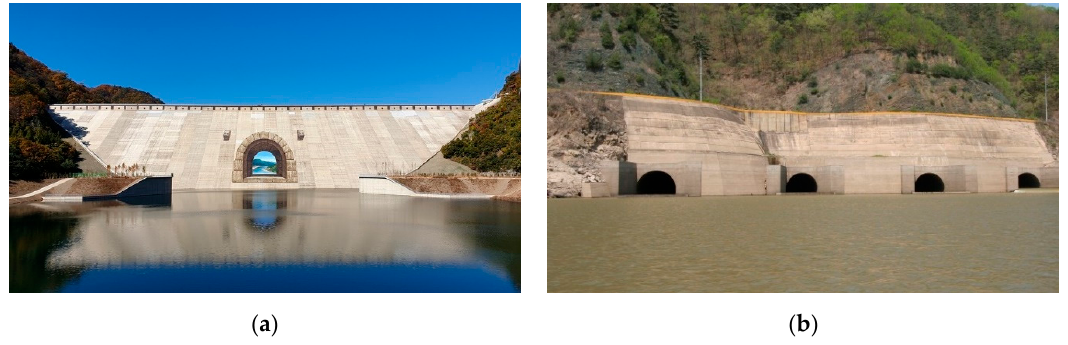
Figure 2. The main body and the outlet of four spillway tunnels of the Peace Dam (The gate at the center of the dam is a trick art titled “The Gate to Reunification”). ( a ) Main body; ( b ) outlet of four spillway tunnels.